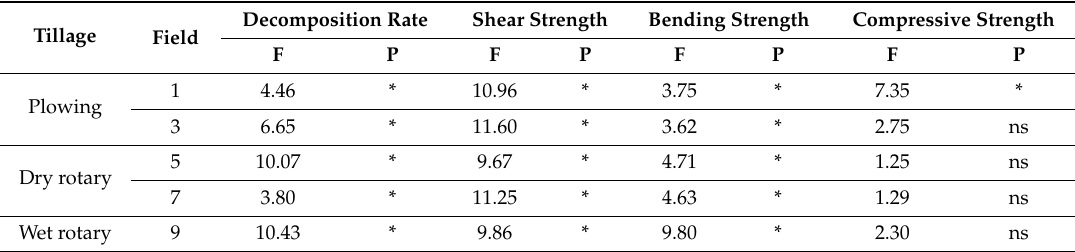
Table 1. One way ANOVA of the wheat straw over